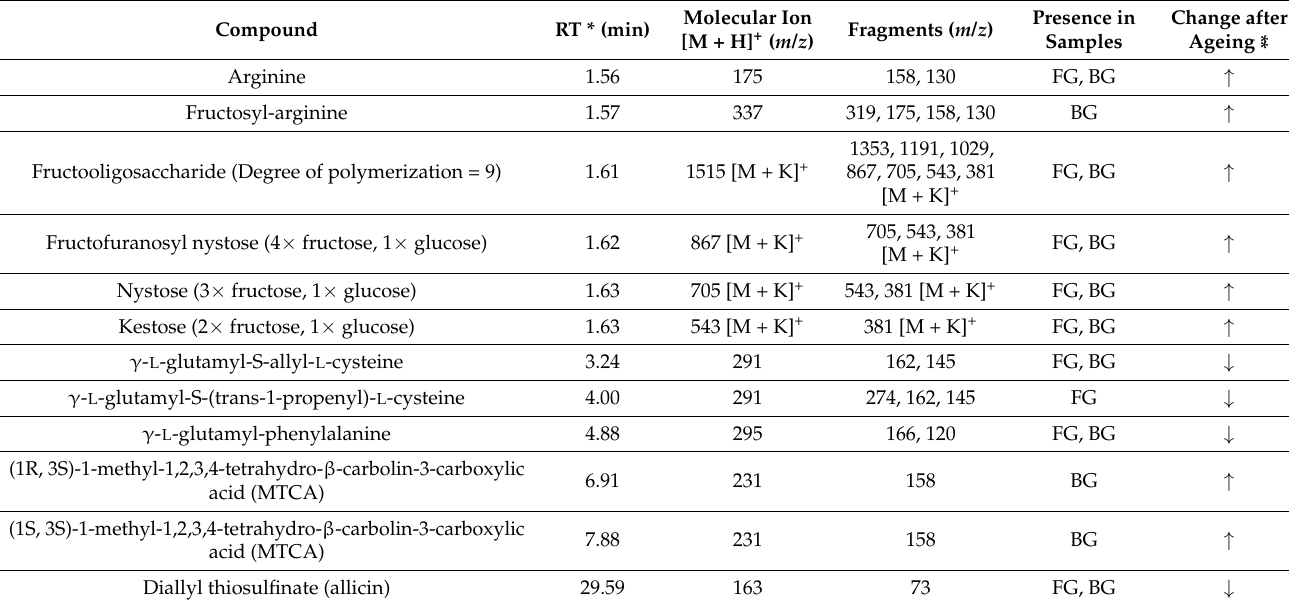
Table 3. Tentatively identified compounds in fresh (FG) and black garlic